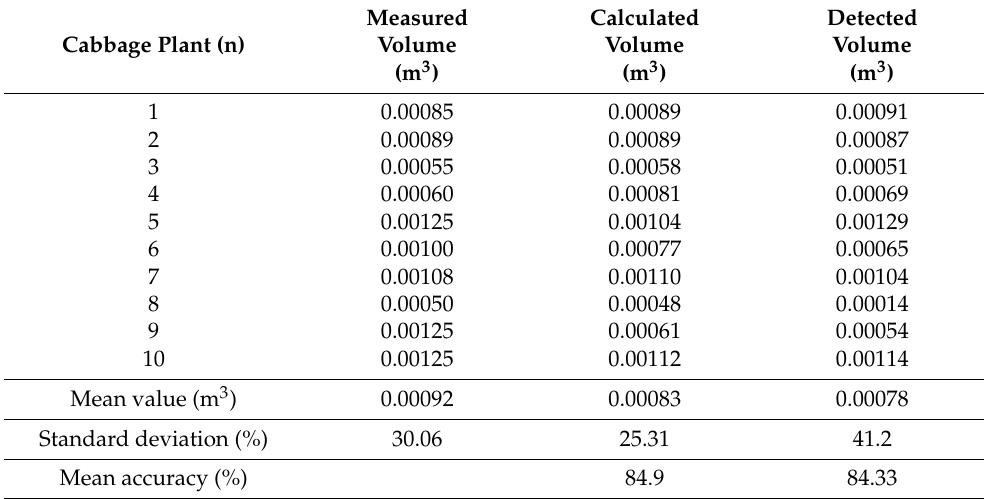
Table 3. Comparison of measured volume, calculated volume, and detected volume in regard to calculated results of BBCH stage